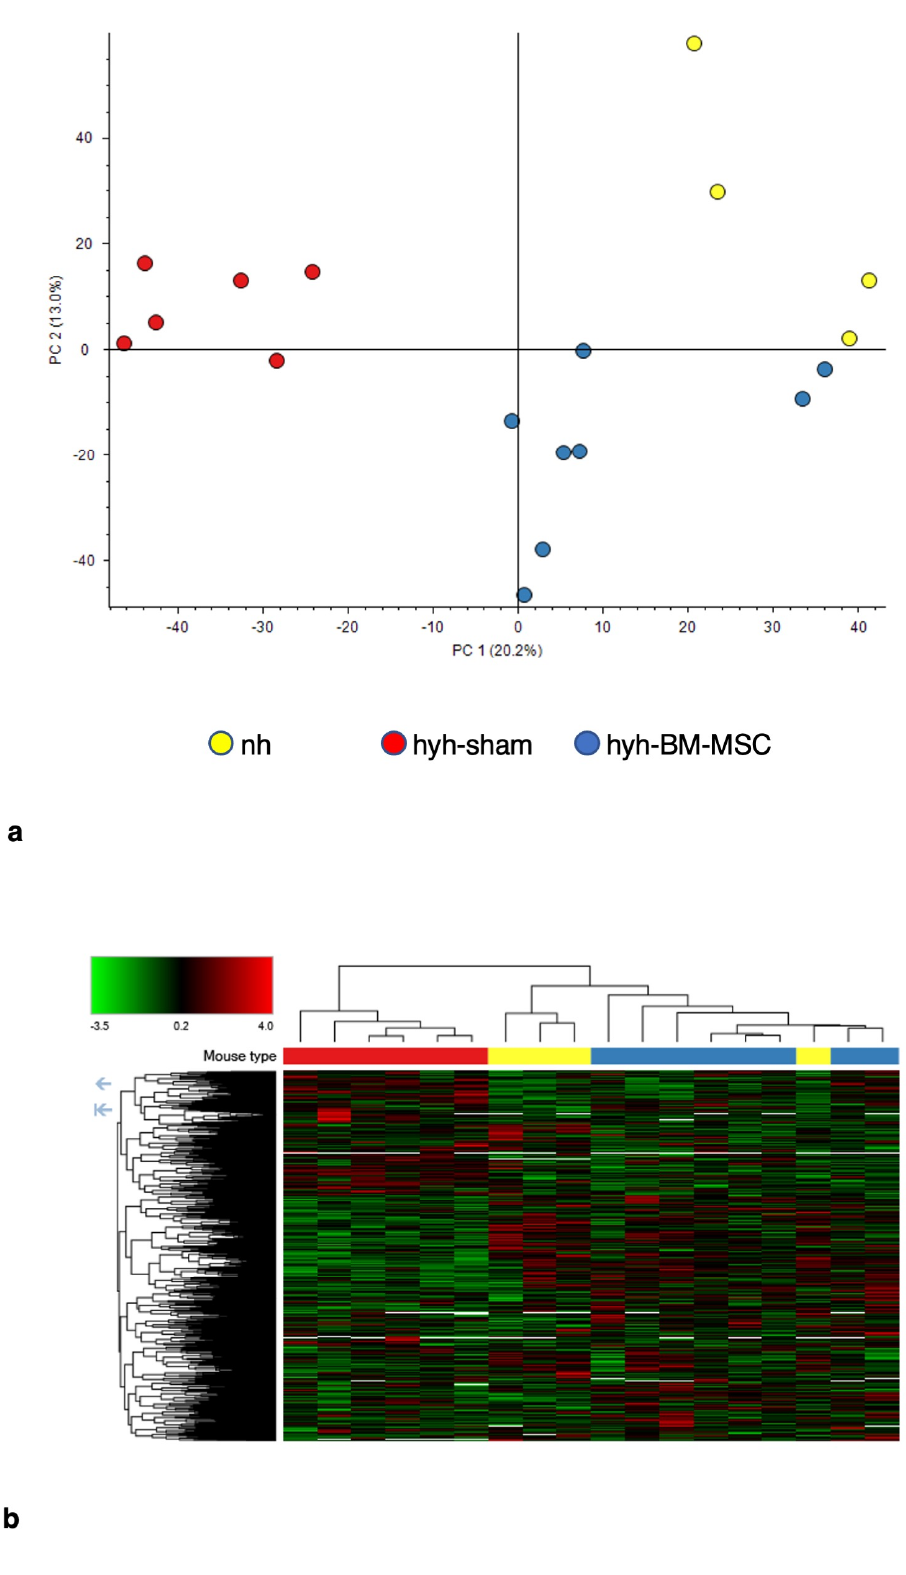
Figure 3. Differential expression of proteins between BM-MSC-transplanted and sham-injected hydrocephalic hyh mice. ( a ) Principal component analysis of the hyh mice treated with BM-MSCs (hyh-BM-MSC, n = 8), hyh mice sham-injected (hyh-sham, n = 6), and nonhydrocephalic normal mice (nh, n = 4). ( b ) Heatmaps and clusters of the three groups of